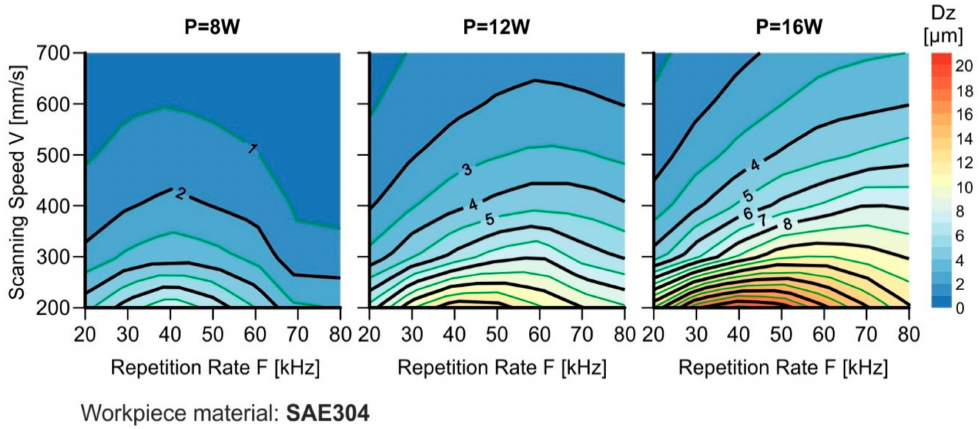
Figure 5. Removed material layer thickness Dz